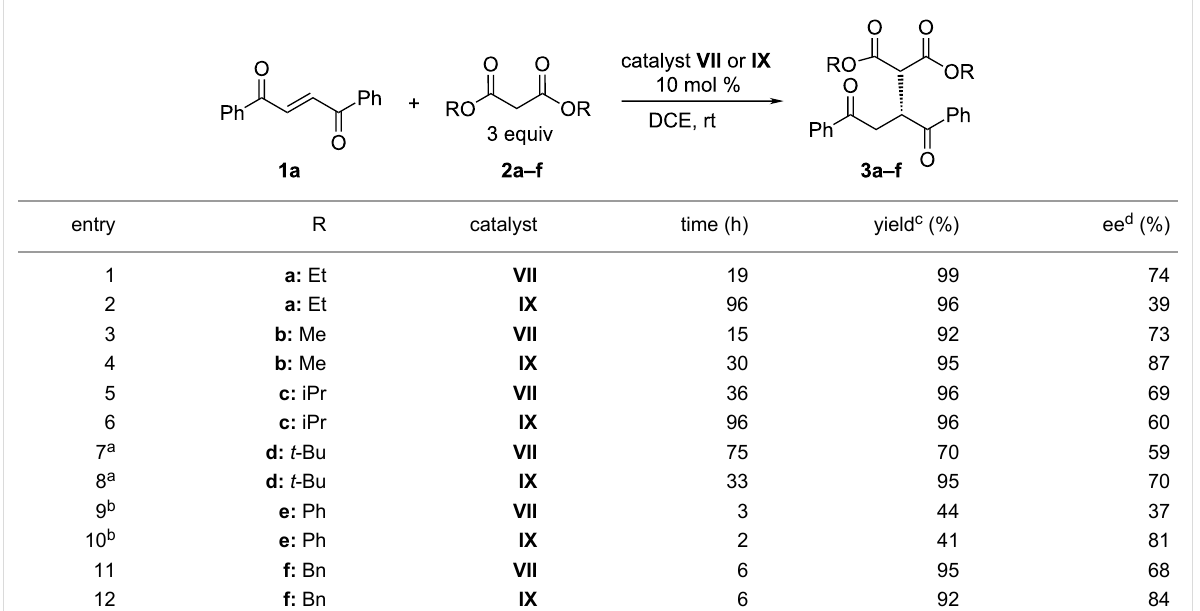
Table 2: Enantioselective addition of malonates 2a - 2f to unsaturated 1,4-diketone 1a .